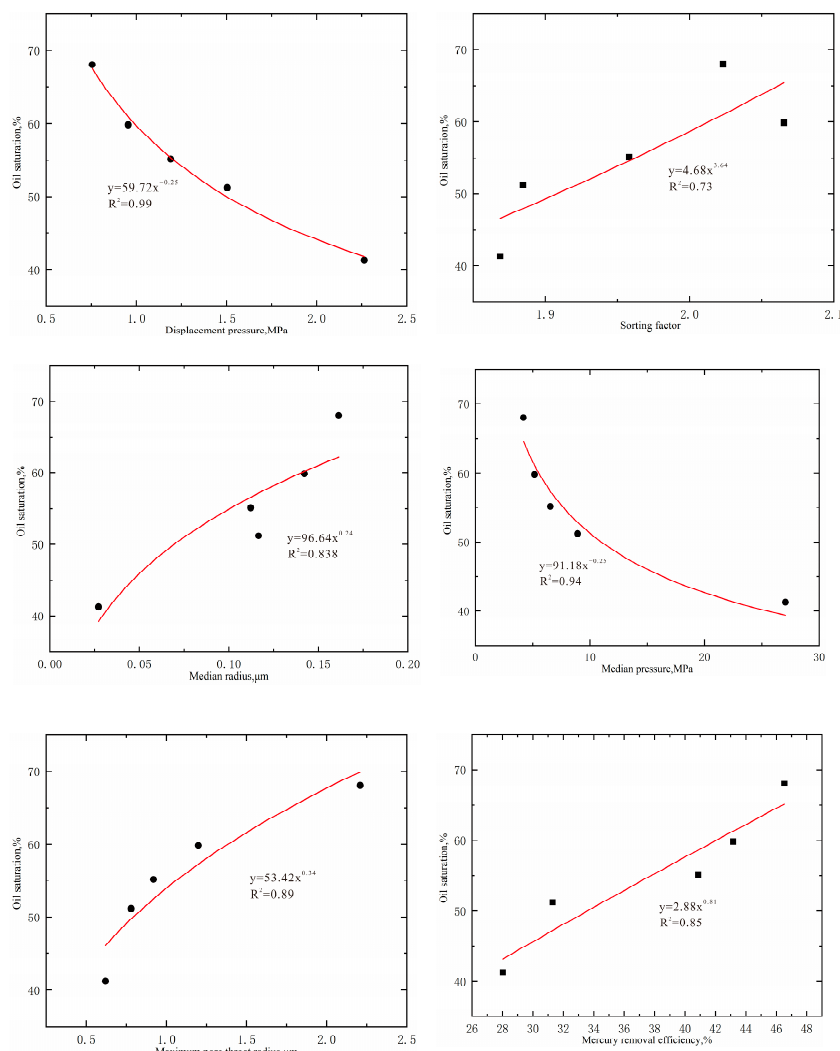
Figure 12. Relationship between oil saturation and displacement pressure, sorting factor, median radius, median pressure, maximum pore throat radius, and mercury removal efficiency.